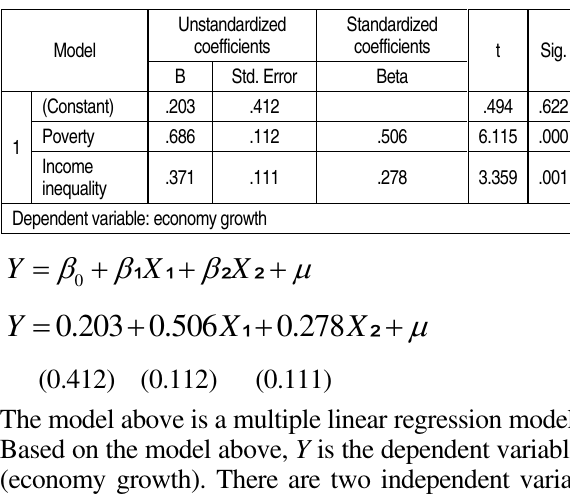
Table 9. Multiple linear regression